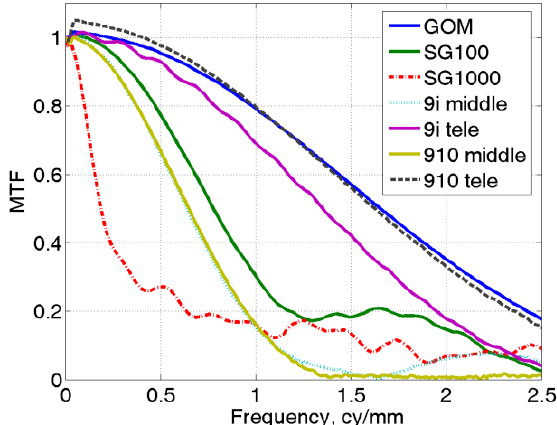
Figure 13. Plot of MTF related to the seven combinations of 3D scanner/lens analyzed in the paper.